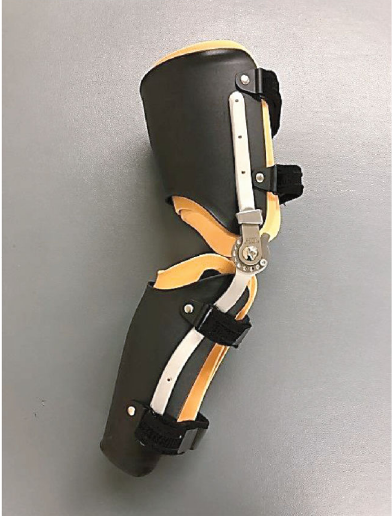
Figure 1: Custom-fabricated knee orthosis. The metal upright knee orthosis can be adjusted by the inner cu ff , with the angle restricted by a dial lock